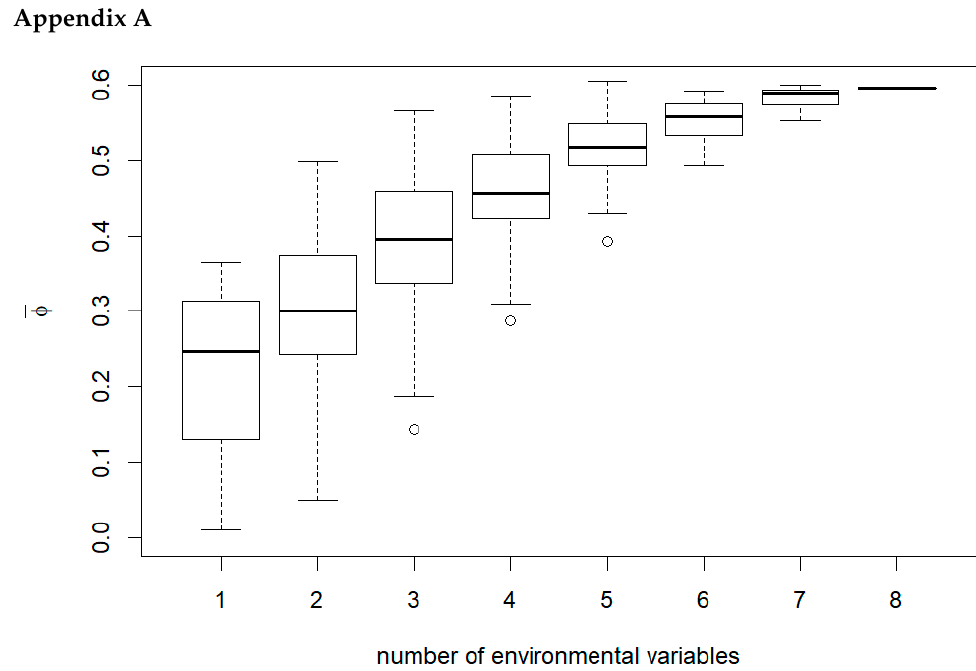
Figure A1. Box plot of mean phi coefficients ( φ ) of the FDMs generated by ETC as affected by the number of explanatory variables. Box plot shows median plus upper and lower quartiles for φ of FDMs with a given number of explanatory variables. Minimum and maximum values are indicated by the upper and lower whiskers (1.5 × interquartile range). Circles are outliers.